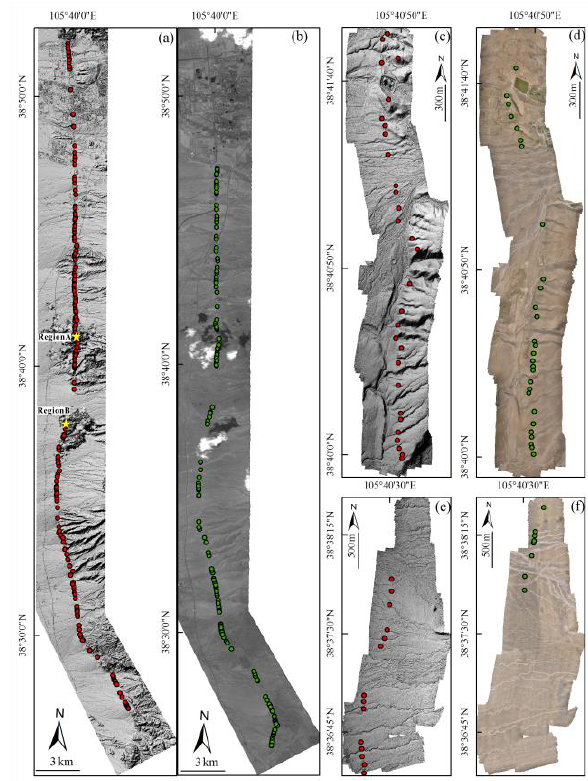
Figure 2. (a) and (b) show the hill-shaded DEM and the orthophoto of the West Helanshan Fault generated from the WorldView-3 stereo satellite imagery respectively. (c) and (d) represent the hill-shade DEM and the orthophoto of region A acquired from the UAV images respectively, while (e) and (f) represent the hill-shade DEM and the orthophoto of region B acquired from the UAV images respectively. The locations of region A and region B are illustrated in Figure 2a where there are heavy clouds in the satellite imagery. The green and red circles indicate the locations of strike-slip and vertical offset measurements respectively.